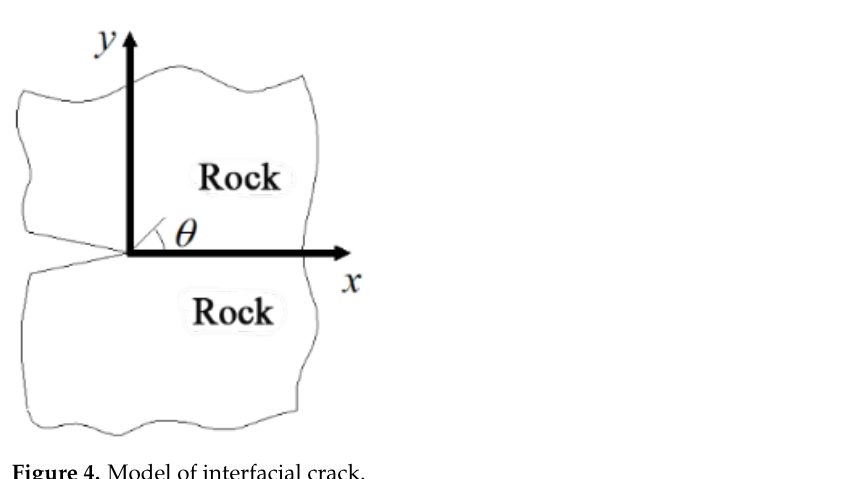
Figure 4. Model of interfacial